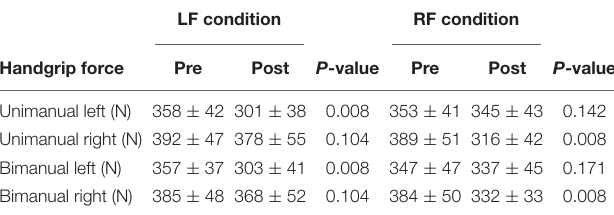
TABLE 2 | Handgrip force at pre and post submaximal fatiguing handgrip task. LF